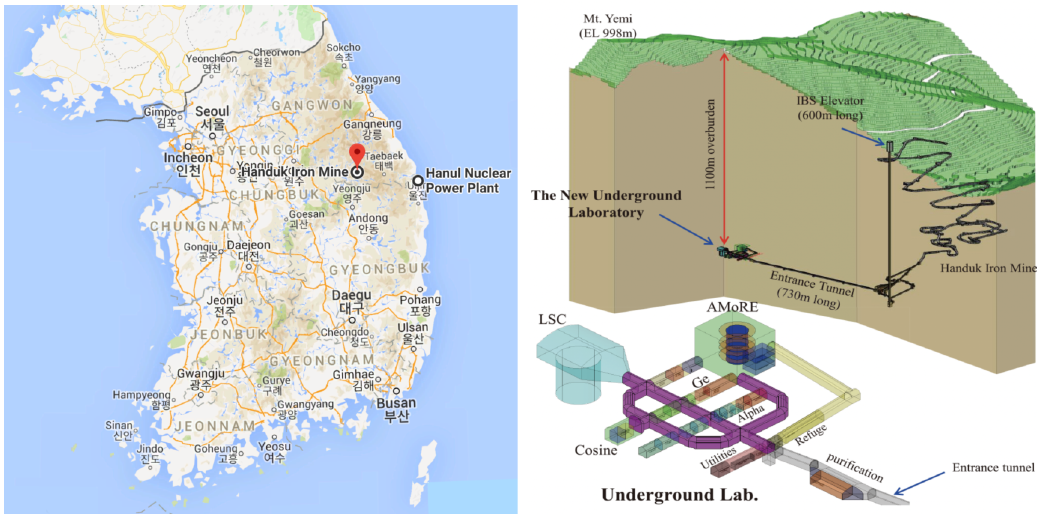
Figure 3 . (Left) The Handuk iron mine location (latitude: 37.188639 deg, longitude: 128.659406 deg) in Jeongseon-gun, Gangwon province, Korea, where a new underground Yemilab ( ∼ 1000 m overburden) is currently being constructed. (Right) The layout of Yemilab, including a cavern for a ∼ 3 kiloton neutrino detector (LSC). The laboratory will be accessed by a 600 m vertical shaft and a 730 m entrance tunnel. Adapted from ref.